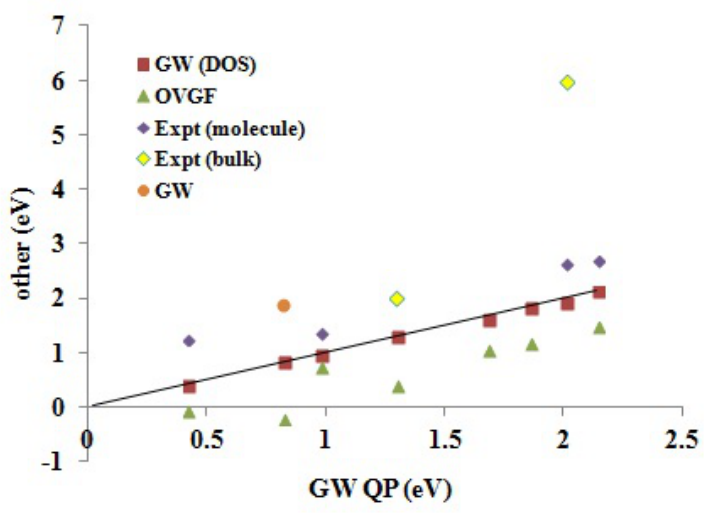
Figure 8. Correlation graph of data from Table 6 showing how experimental and Green’s function EAs compare. The label “ GW ” (as opposed to GW DOS and GW QP) is the calculated values taken from the literature (see Table 6).